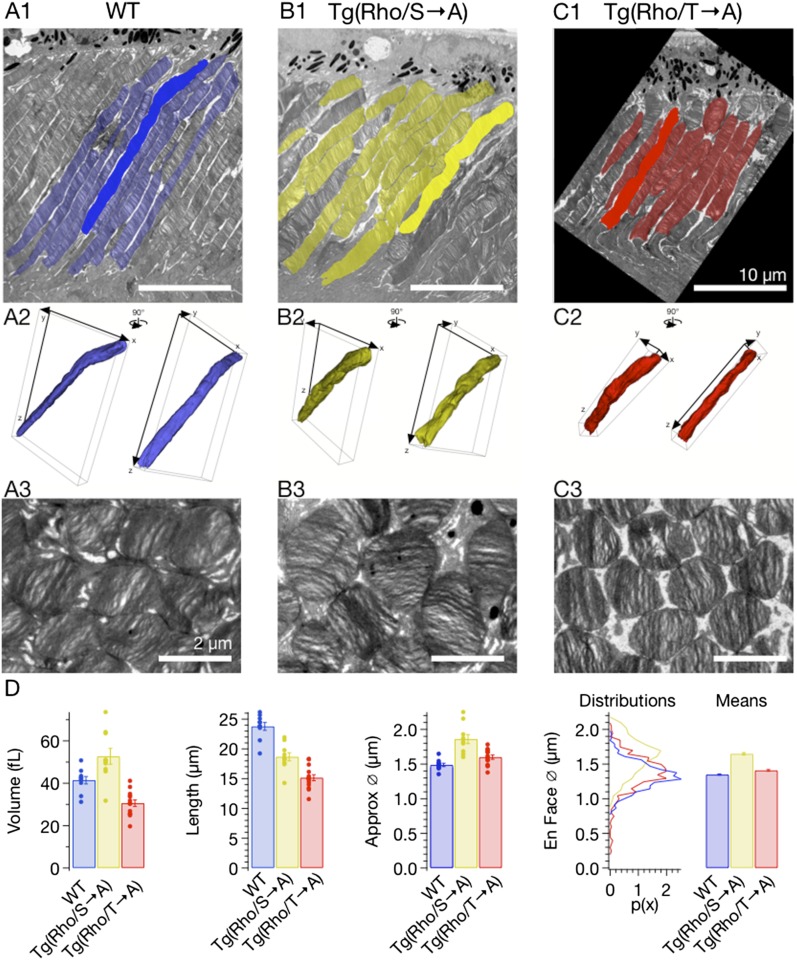
Ectopic expression of rhodopsin mutants modestly alters rod morphology.(A–C) Serial EM images of rod outer segments were segmented by hand and reconstructed in TrakEM2. (A1–C1) EM micrographs of 80-nm section of outer segments with segmented rods indicated in colors. Scale bar 10 μm. (A2–C2) 3D representation of highlighted rods in A1–C1 from two different viewing angles, rotated 90° about vertical. (A3–C3) En face section of the same retinas showing rod outer segment cross sections. Scale bar 2 μm. (D) Comparison of rod morphology across strains. Volume, length, and approximate diameter (Approx. Ø) were calculated from reconstructions, while en face diameter (En face Ø) was measured from segmentation of en face micrographs. T → A and WT approximate diameter measurements are not significantly different. Otherwise, all measurements are significantly different (p < 0.01, one-way ANOVA, corrected for multiple comparisons).